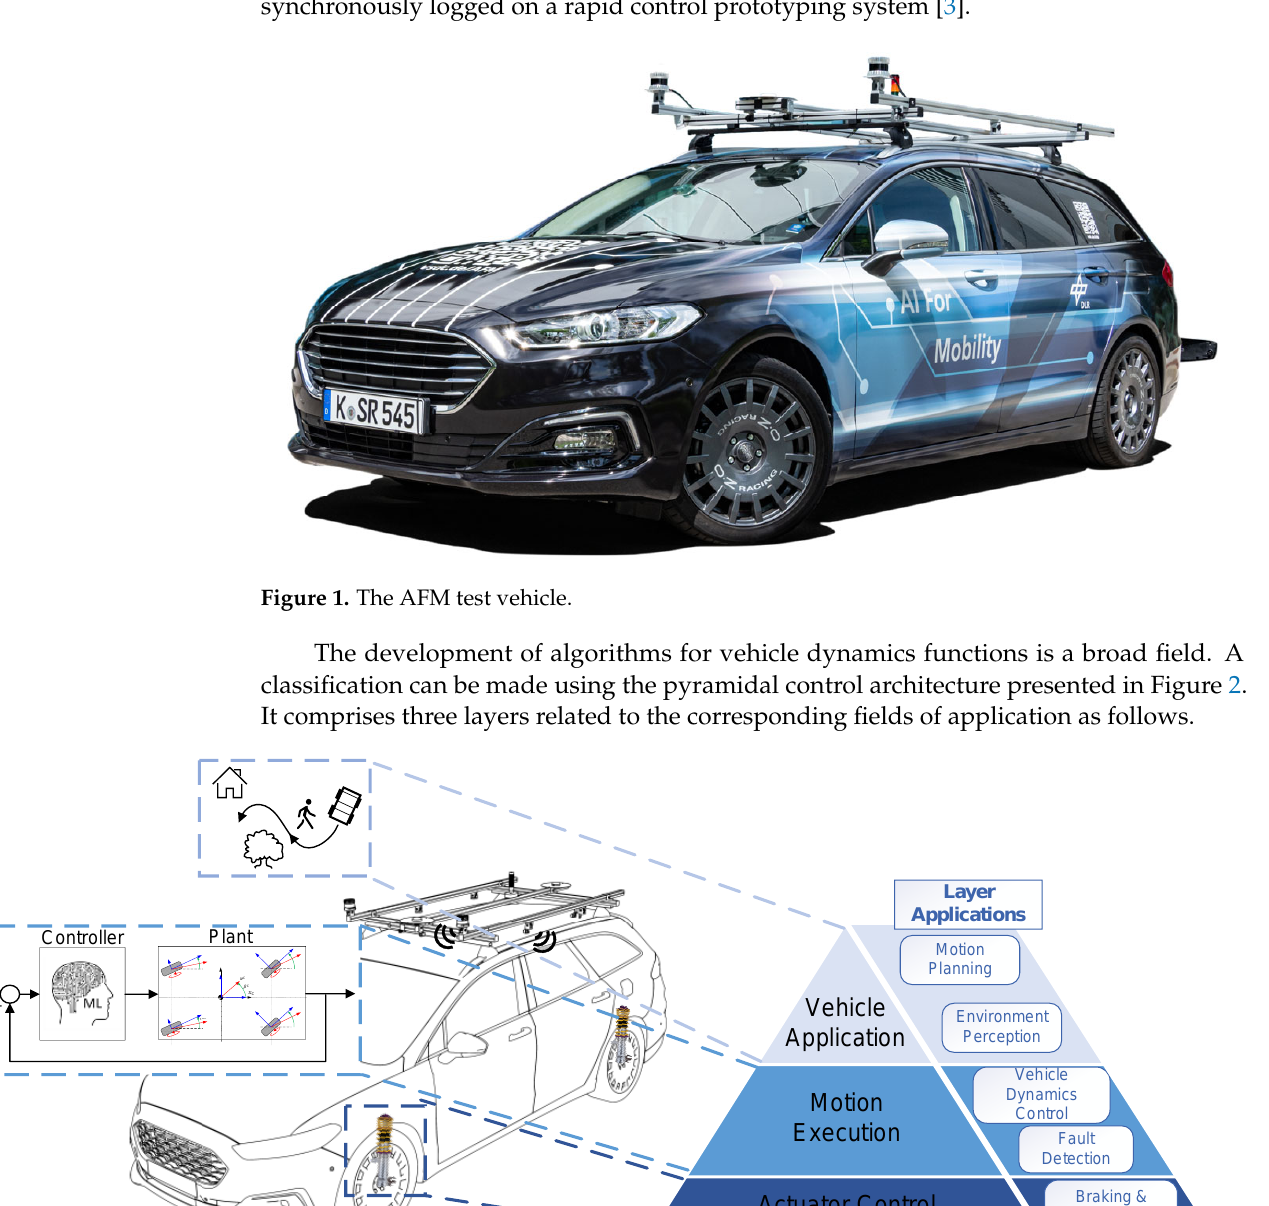
Figure 2. The DLR ‐ SR scalable vehicle dynamics control architecture and its applications, fully ad ‐ dressed by the AFM, extended from [4]. Vehicle Application Layer The top layer deals with the vehicle application and is used to generate trajectories or paths. Motion planning is performed on the basis of environmental information. For this purpose, the AFM is equipped with various perception sensors such as cameras, lidar or radar sensors. By means of advanced machine learning methods, the driving environ ‐ ment is recorded and processed in real ‐ time. The resulting motion requirements for the three planar degrees of freedom are passed to the Motion Execution layer. Motion Execution Layer This layer contains the vehicle dynamics control, which calculates appropriate vehi ‐ cle dynamics quantities to realize a required motion and ensures the safe operation of the